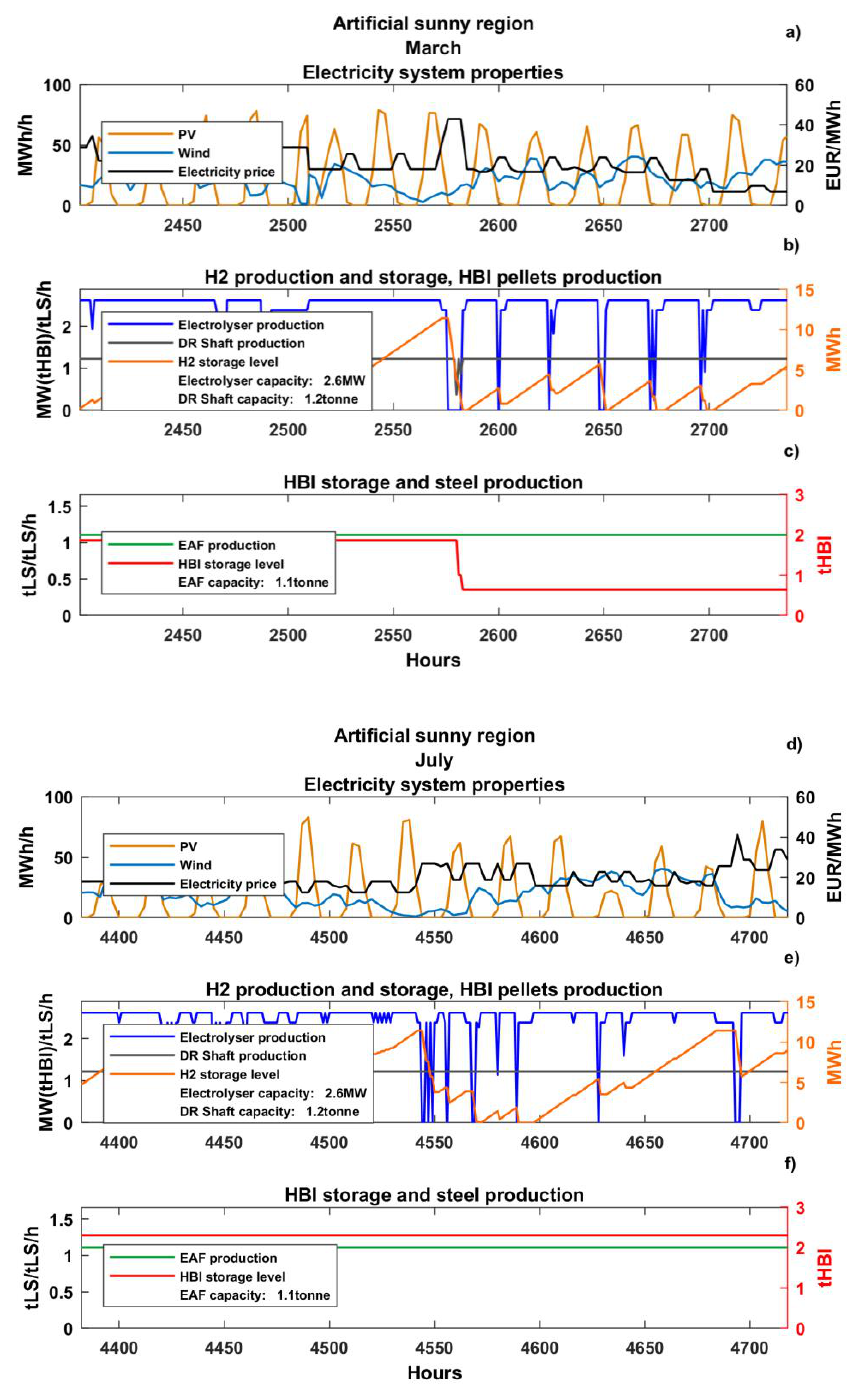
Figure 8. Levels of generation of PV and wind power (MWh/h) and electricity price profiles (EUR/MWh) ( a , d ); production levels of the electrolyser and DR shaft furnace (MW (tHBI)/tLS/h) and state of charge of the hydrogen storage (MWh) ( b , e ); production levels of the EAF (tLS/tLS/h) and state of charge of the HBI storage (tHBI) ( c , f ), in an artificial sunny region for 2 weeks in March (upper plots) and in July (lower plots) in the year 2050.